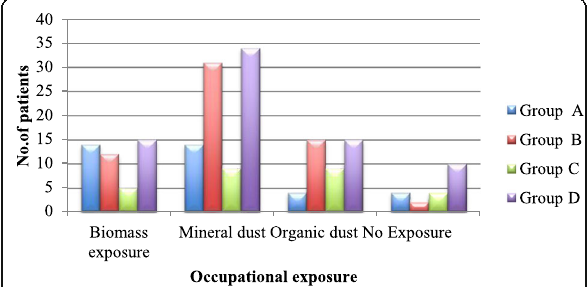
Fig. 11 Distribution of occupational exposure with severity grouping